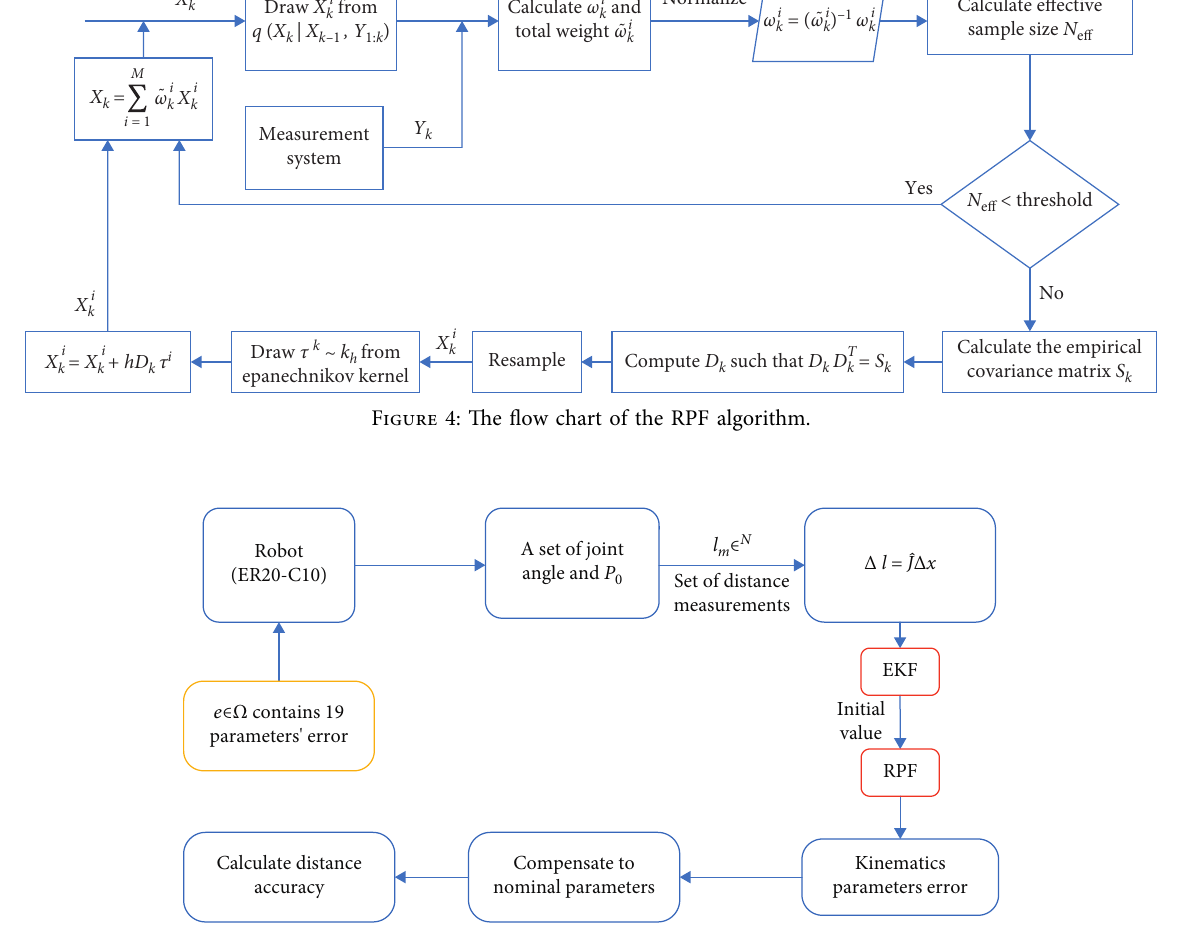
Figure 5: The flow chart of the proposed algorithm. Table 2: Settings of the kinematic parameters’ error.